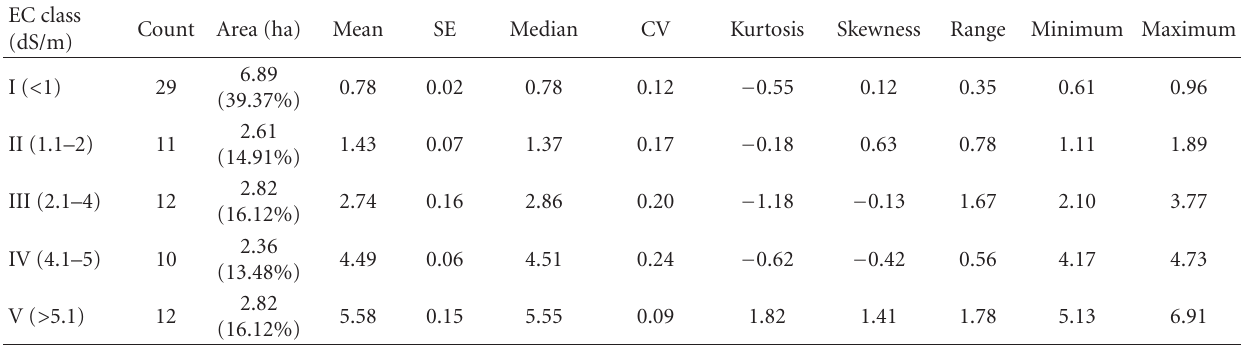
Table 5: Five classes of EC 1:1 , number of count in each class, area, mean, standard error (SE), median, coe ffi cient of variation (CV), kurtosis, skewness, range, minimum (min), and maximum (max) at 0–20 cm depth during 2010.